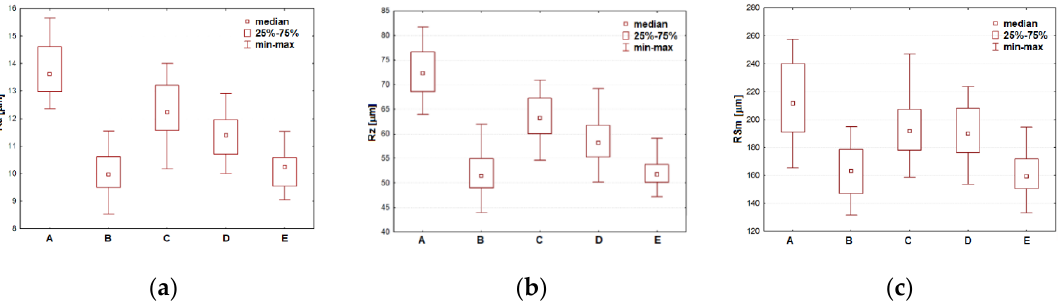
Figure 9. Box plots for roughness parameters ( a ) Ra, ( b ) Rz, and ( c ) RSm in particular positions.